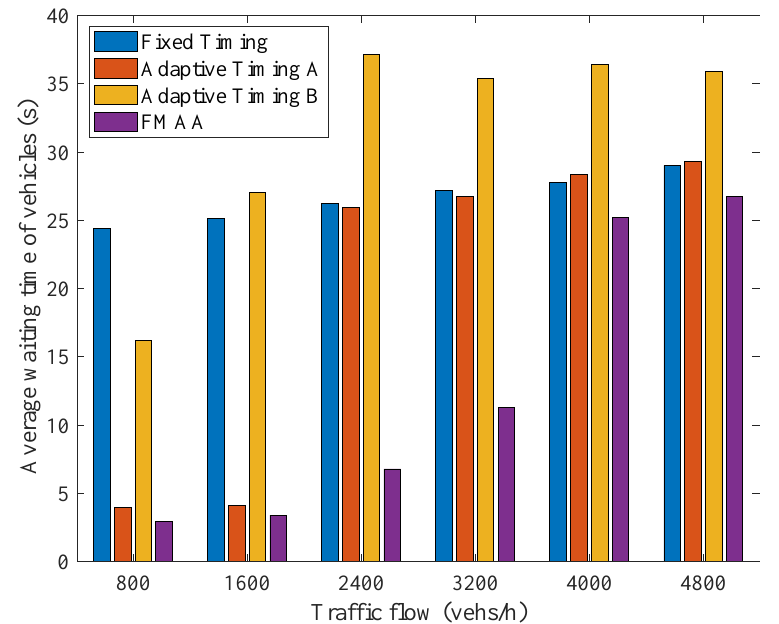
Figure 6. Average waiting time of